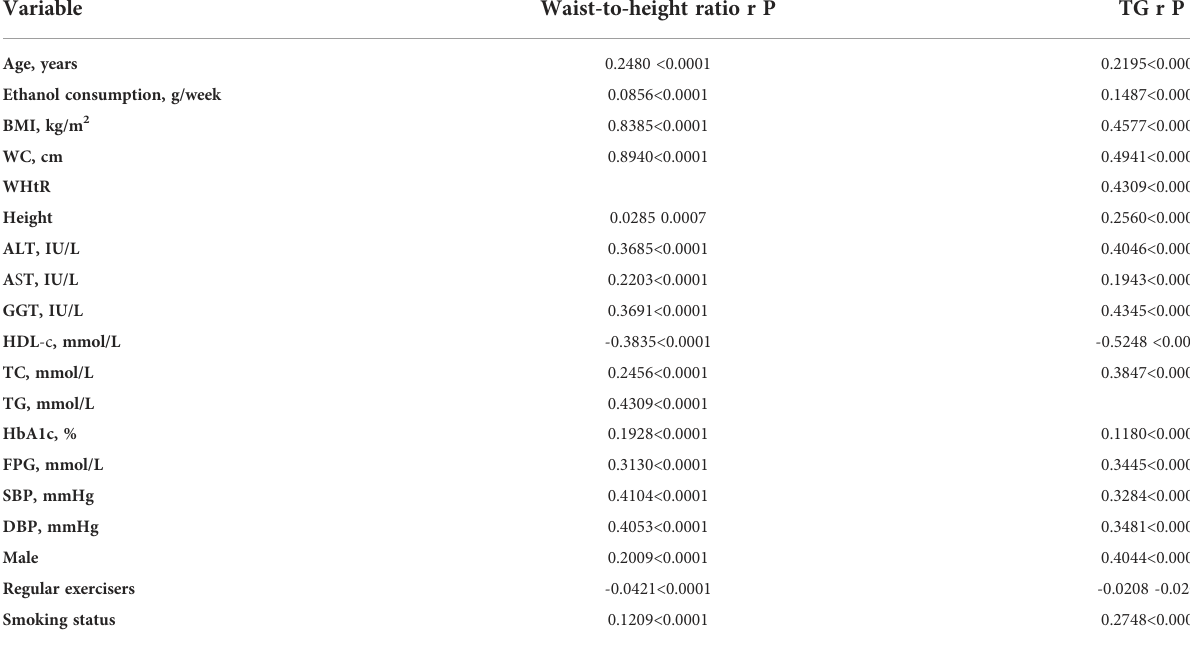
TABLE 2 Spearman ’ s correlation of WHtR or TG with potential risk factors of non-alcoholic fatty liver disease. Variable Waist-to-height ratio r P